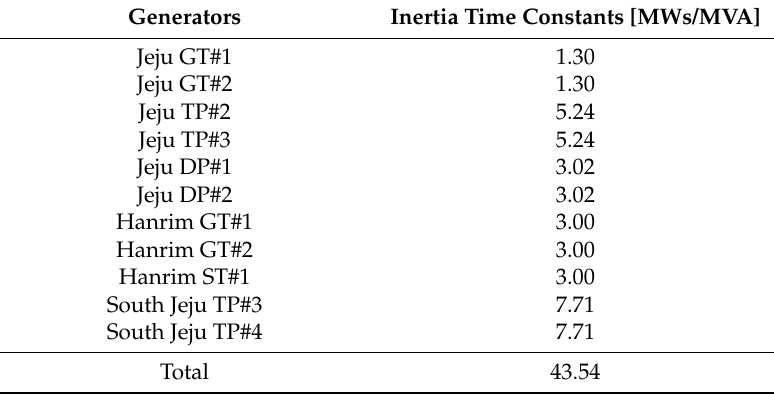
Table 1. Inertia time constants of each